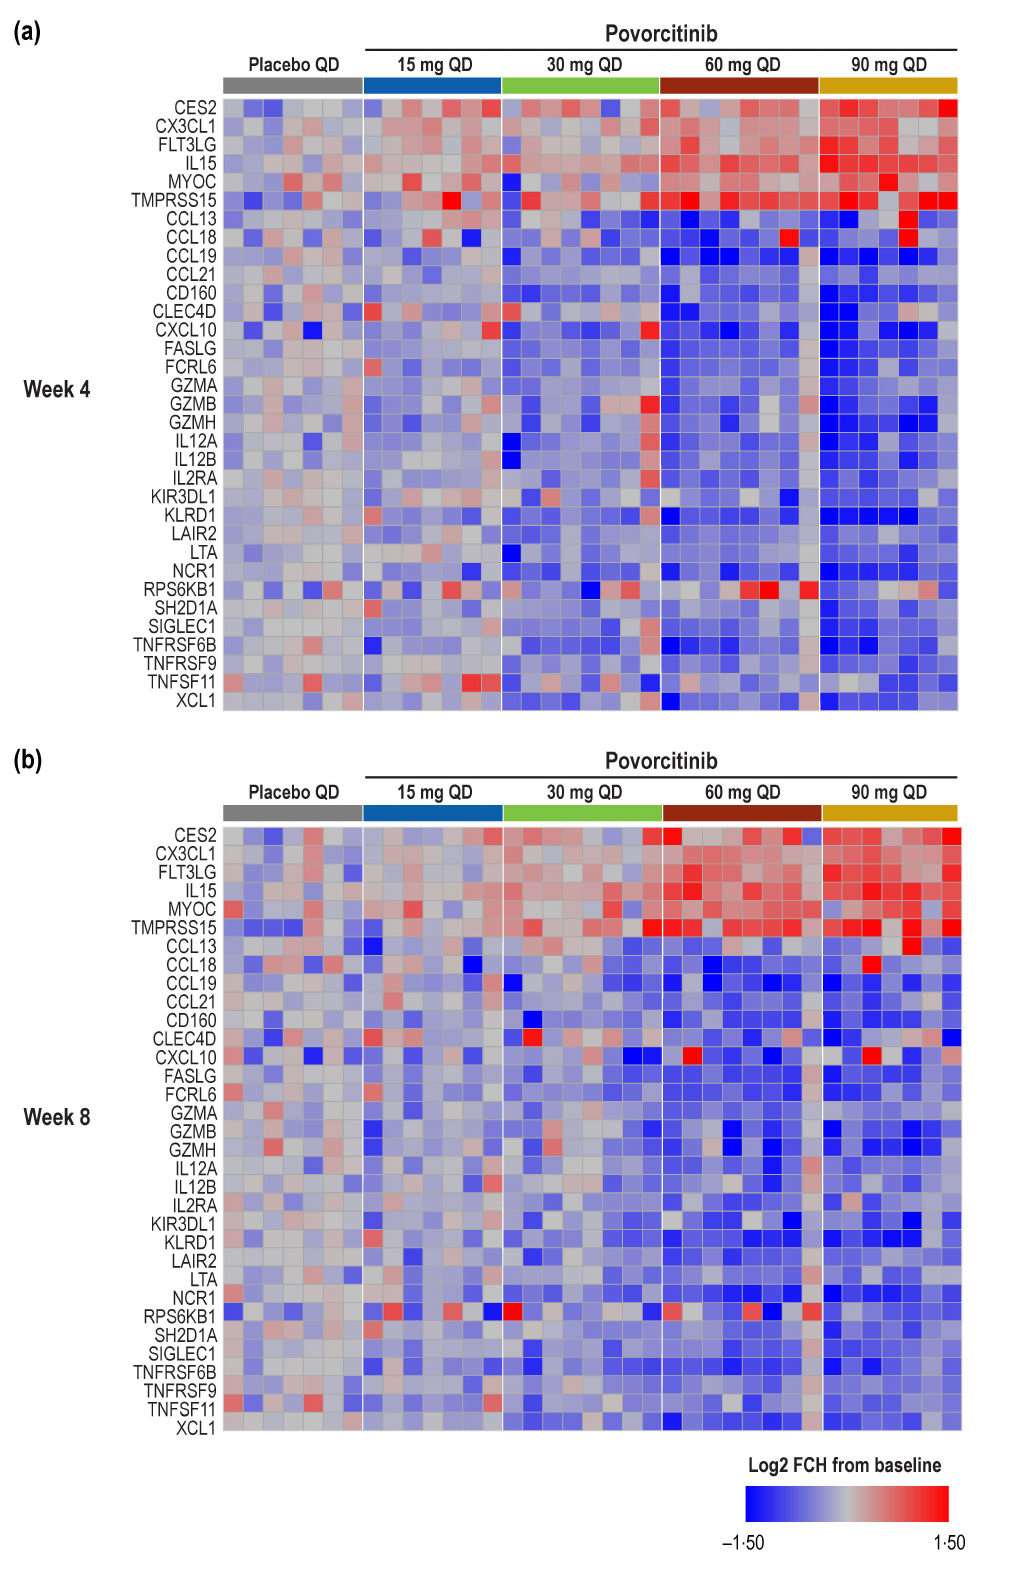
Figure 5. Heatmap of DEPs in blood samples by treatment. ( a ) Week 4, ( b ) Week 8. DEP, differentially expressed protein; |FCH|, absolute fold change; FDR, false discovery rate; QD, once daily. The cutoff for significance was FDR < 0.05 and |FCH| >